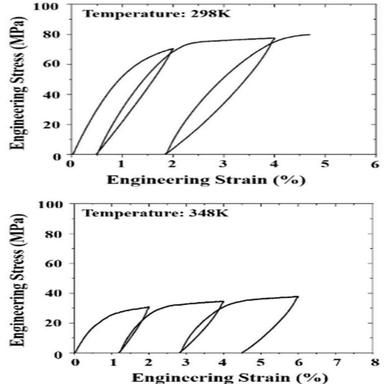
Loading and unloading test of underfill at 298K and 348K